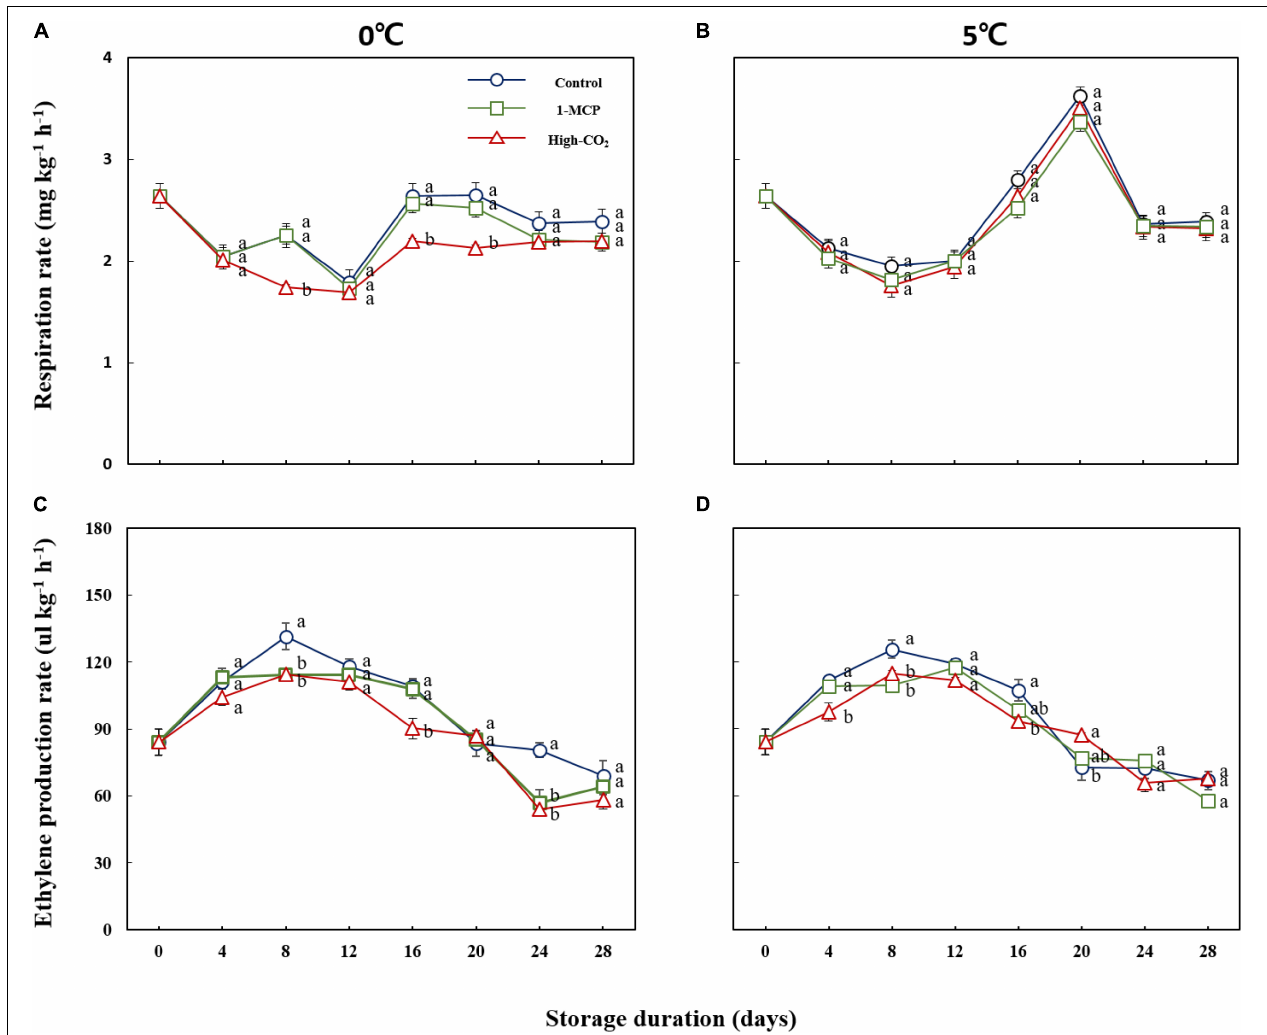
FIGURE 2 | Respiration (A,B) and ethylene production rates (C,D) of Madoka peach fruit at harvest and during storage up to 28 days at 0 and 5 ◦ with or without prestorage treatment of CO2 and 1-MCP.